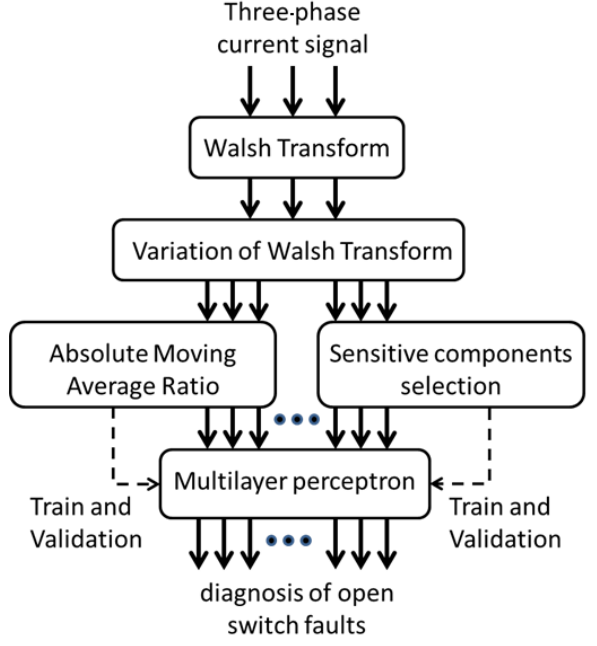
Figure 2. Structure of the proposed incipient WT-MLT fault diagnosis method.